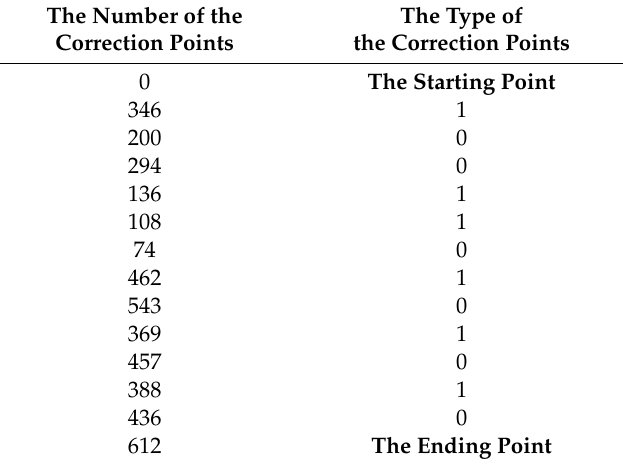
Table 3. Corrects result for Problem 2.